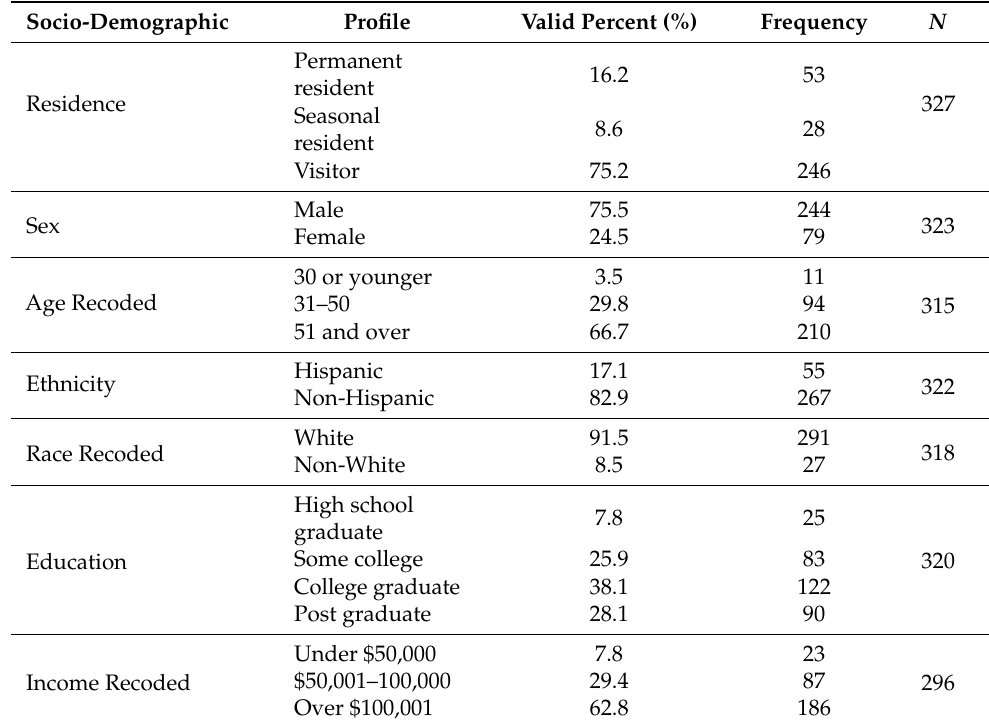
Table 2. Socio-demographic profile of survey respondents, shown with frequency and percentage of responses for each optional survey